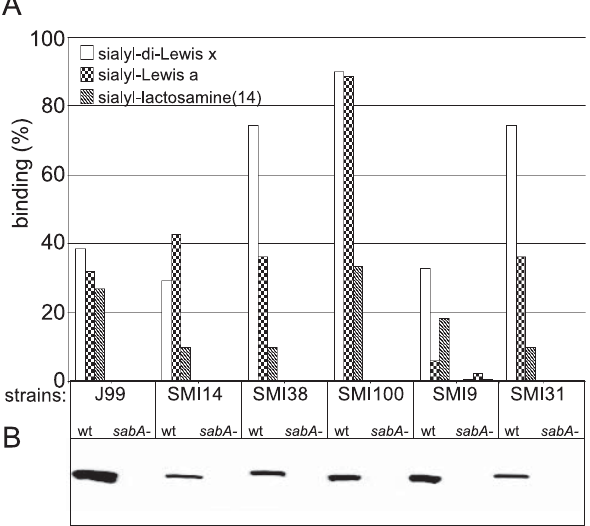
Figure 7. Analyses of Binding Affinities for Sialylated Antigens by SabA from Strain J99 Complementarily Expressed in Background Clinical Strain SMI9 Binding affinities of H. pylori strains J99, SMI9, and the complementation mutant SMI9 sabA J99 were analyzed according to Scatchard. Binding affinities and the percentage ratio of sLex/sLea binding affinities are